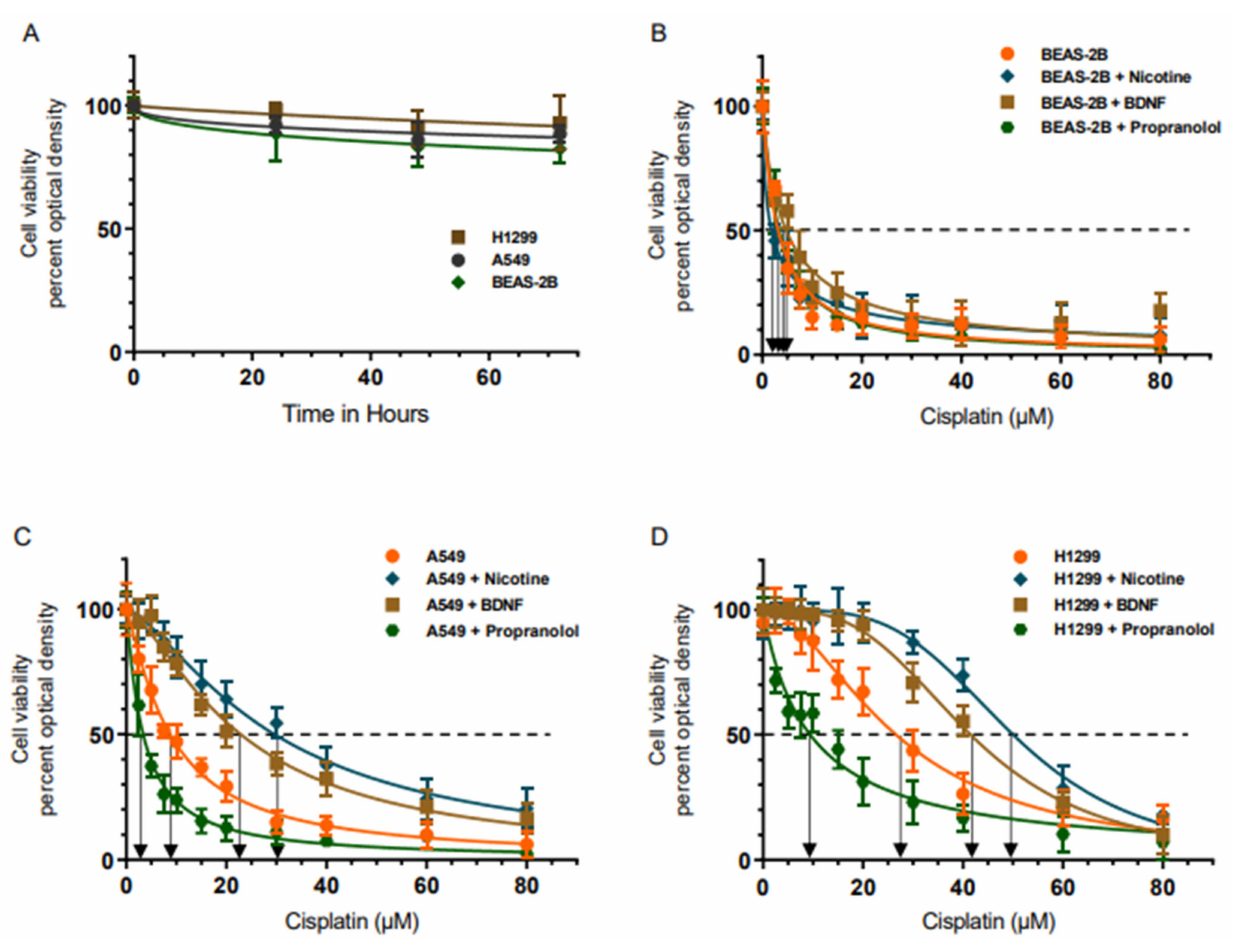
Figure 1. Treatment of A549 and H1299 cells, but not BEAS-2B, with either nicotine or BDNF, increased cell resistance to cisplatin, while the opposite was observed upon treatment with propranolol. Cells were grown to confluence then serum starved overnight. The cell monolayers were then incubated in serum-free media for 72 h in the absence of any treatment ( A ), presence of increasing concentrations of cisplatin without or with nicotine (1 µ M), BDNF (5 nM), or propranolol (1 µ M) ( B – D ). Cell viability of ( A ), BEAS-2B ( B ), A549 ( C ), and H1299 ( D ) was then measured and normalized to cell number (absorbance/cell number), as described in the Methods section. Optical densities (570 nm) were normalized for the curves by expressing each point relative to the best fitted Emax value (set to 100%). The data were then plotted as a function of time or increasing cisplatin concentrations and fit using the GraphPad Prism 9.4.1 software with a nonlinear regression curve fitting approach. Data were expressed as the mean ± S.D. of three independent experiments, each carried out in